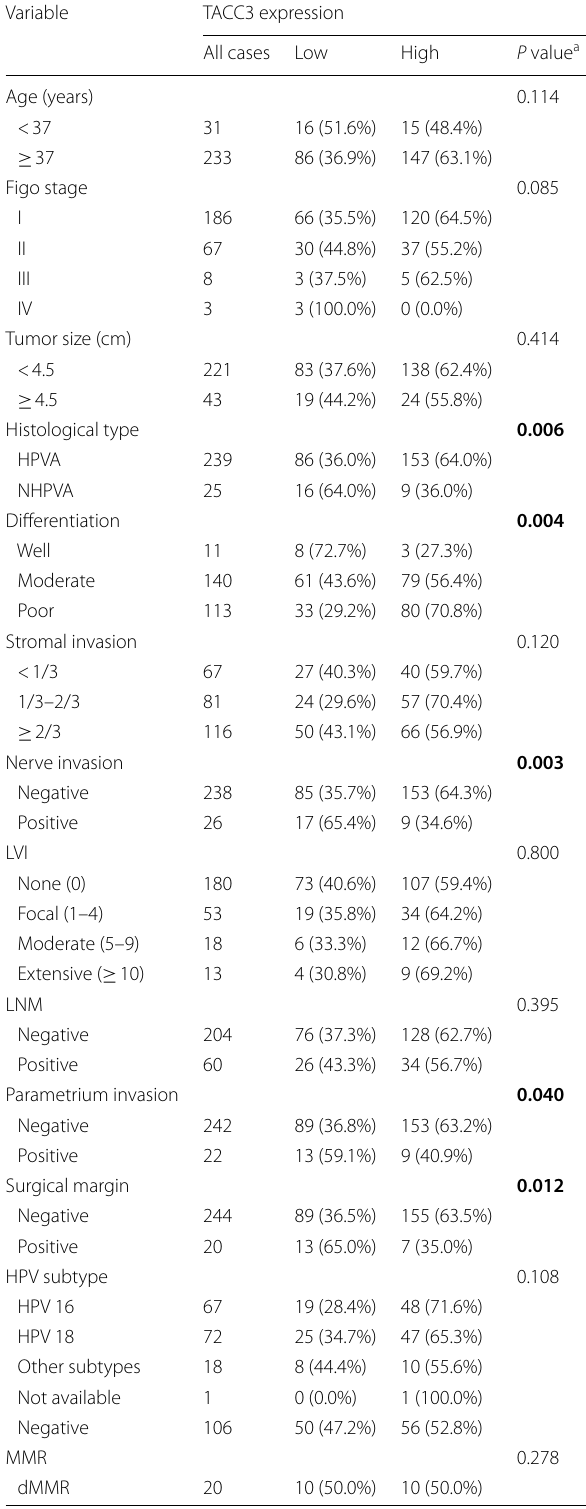
tional file 5: Table S2). ROC curve analyses showed that the combination of TACC3 expression with HPV sub- types improved diagnostic performance over those of TACC3, P16, and HPV subtypes alone (Fig. 5b and Addi- tional file 1: Table S2). The correlation of TACC3, P16, and HPV subtypes was also assessed (Fig. 5c and d). We found that 59.7% (157/263) of ECA cases were associ- ated with HPV, particularly with HPV strains 16 and 18. For different HPV subtypes, the positivity of P16 for the diagnosis of ECA was much higher than that of TACC3